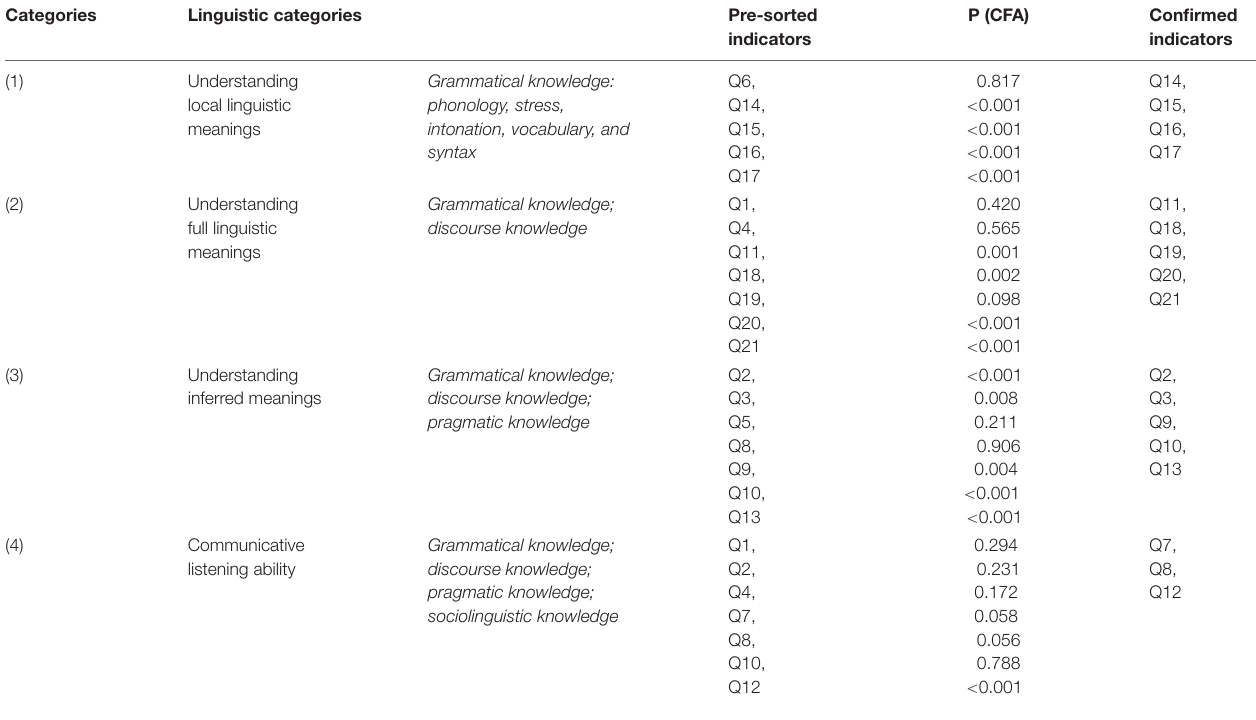
TABLE 3 | Types of language competence with indicators and the CFA